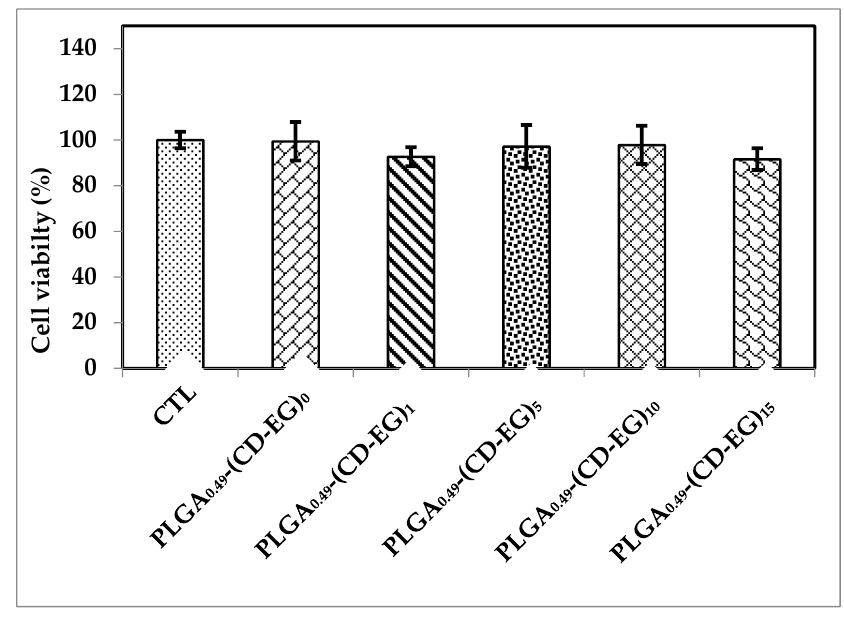
Figure 6. Cell viability of PLGA 0.49 -(CD-EG) 15 at a concentration of 1 (µm/mL) on BV-2 microglial cells.